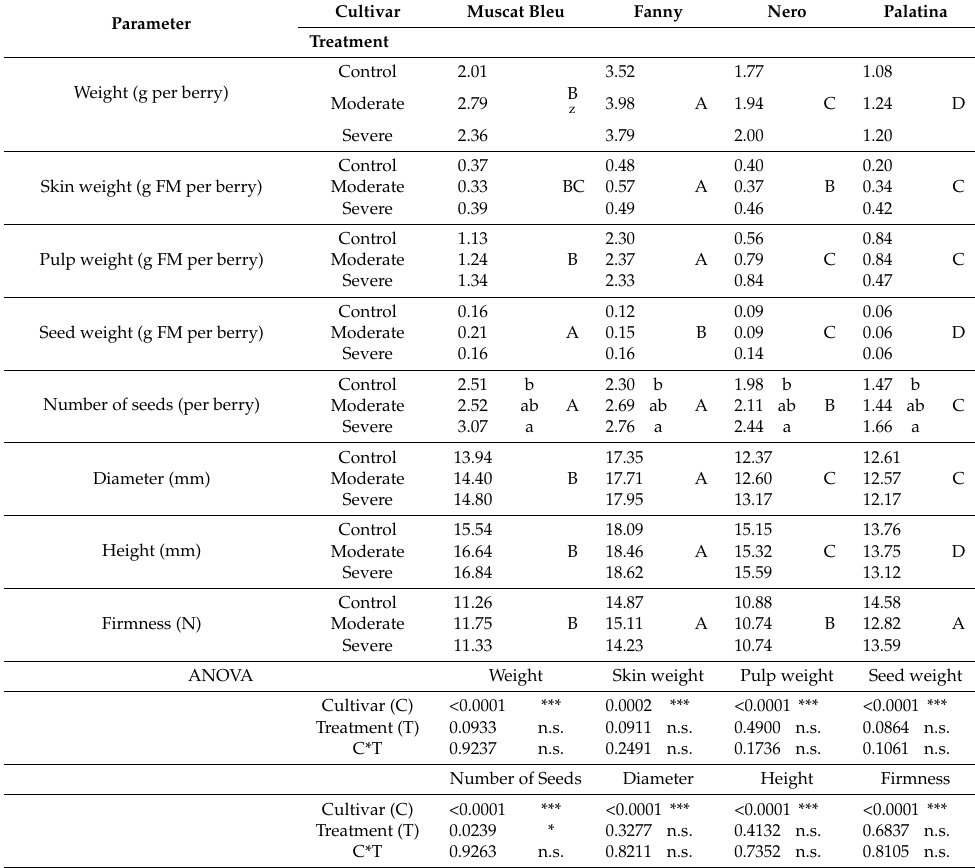
Table 3. Table grape yield and quality parameters on the berry level: Single berry weight, weights of skin, pulp and seeds, diameter, height, and firmness of four three-year-old table grape cultivars under three water deficit treatments in 2016. Cultivar Muscat Bleu